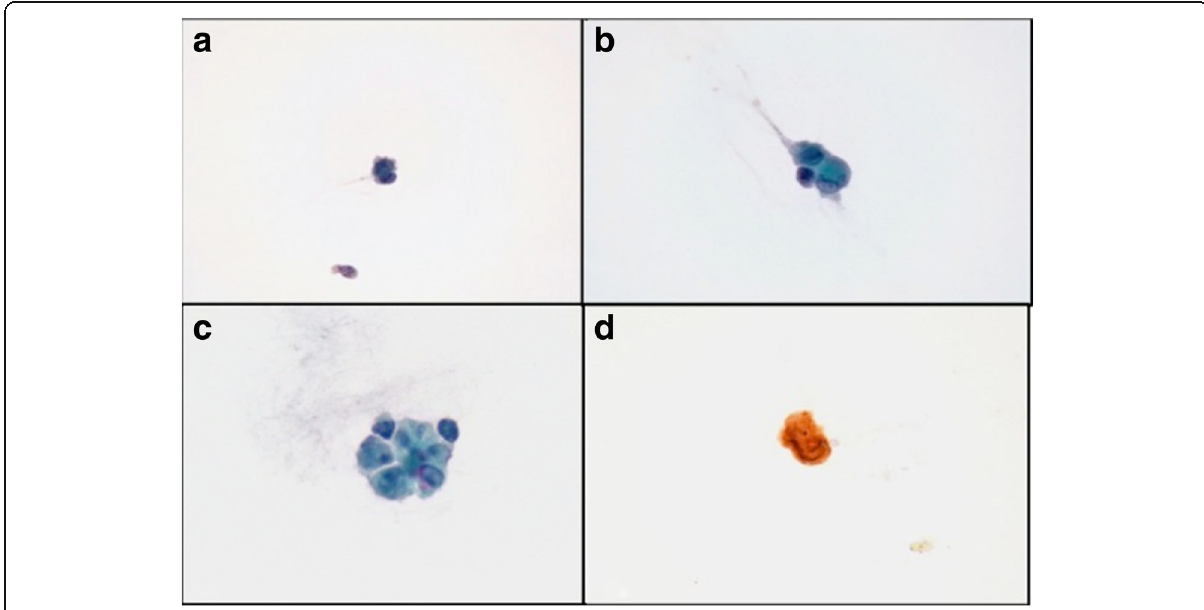
Fig. 2 Pathologic analysis showing dissociated cells forming irregular groups with atypia ( a – c ), positive for HMB45 by inmunohistochemistry ( d ) consistent with a metastatic origin from a cutaneous